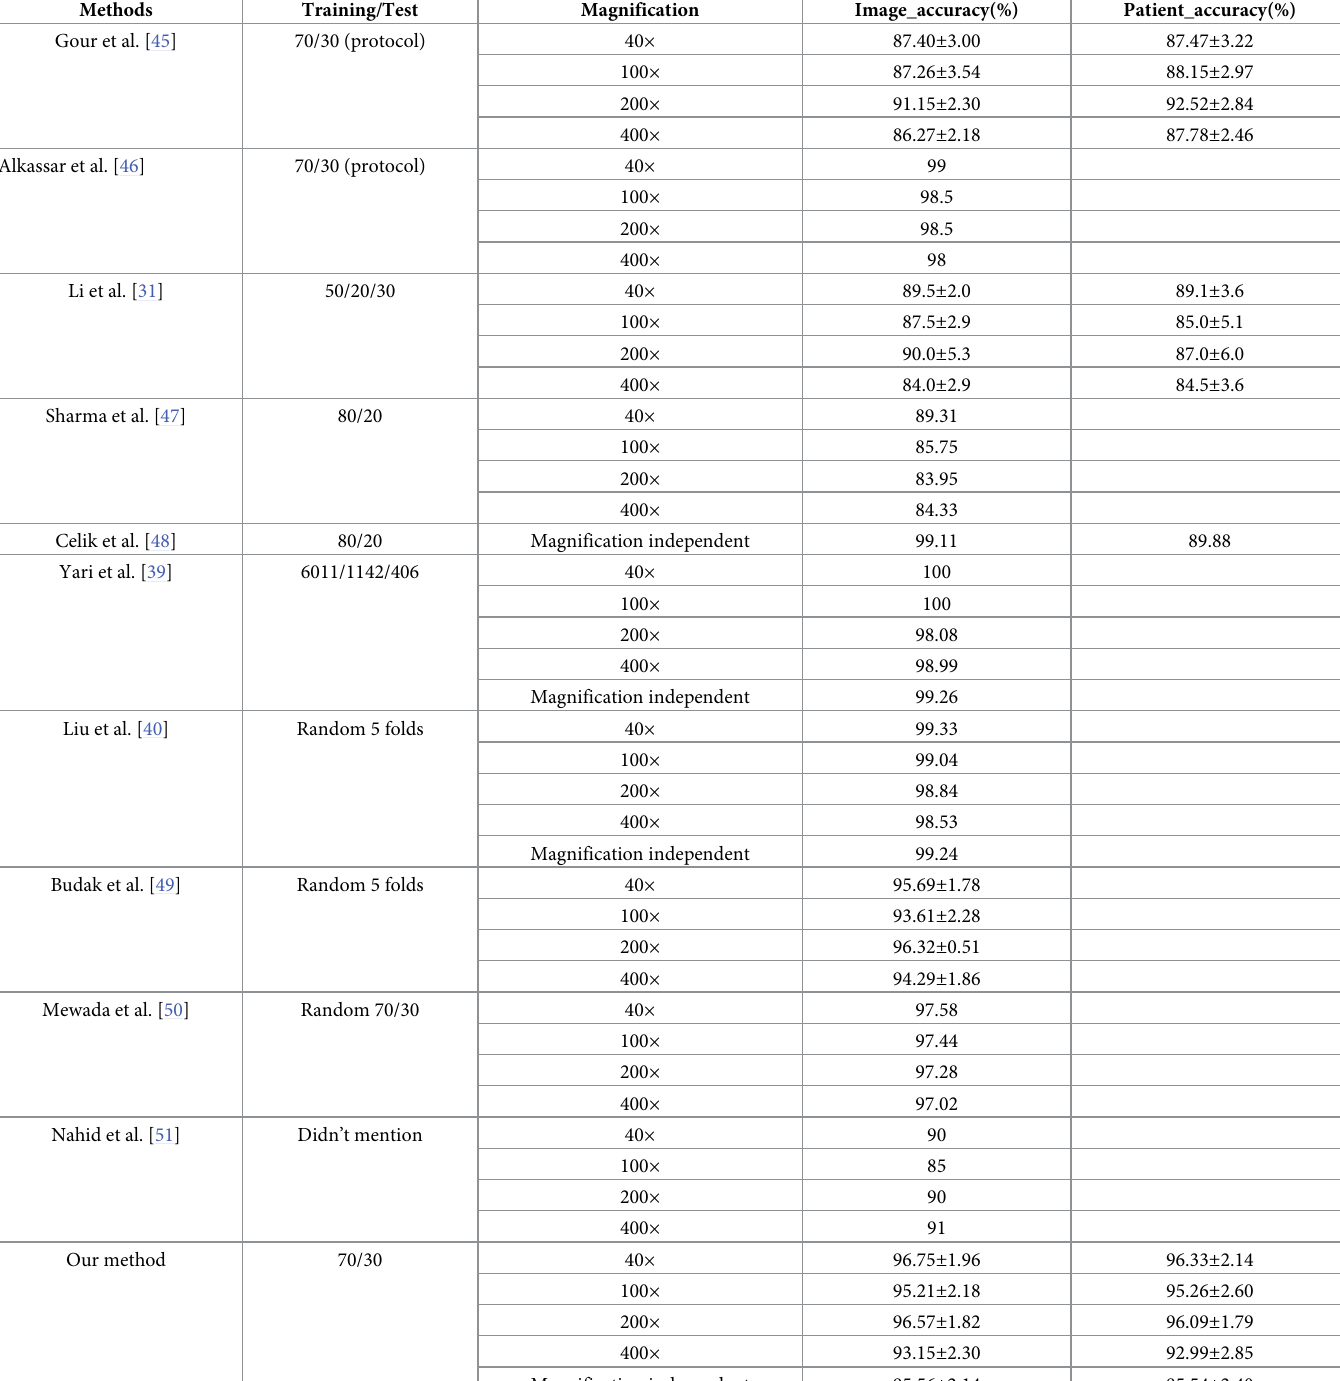
Table 7. Comparison of results between proposed method and the state-of-the-art